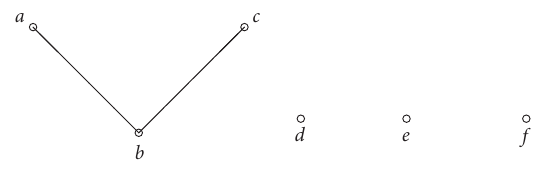
Figure 7: Figure of S for Example